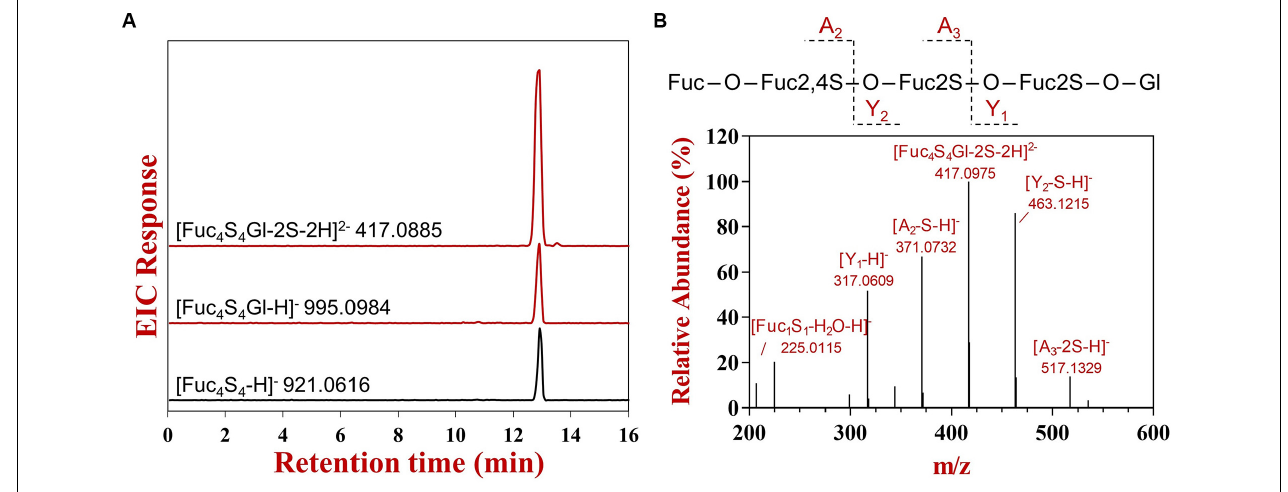
FIGURE 4 | The UPSEC-MS analysis of hydrolysis and transglycosylating products produced by FunA in the reaction system with glycerin as the acceptor. (A) Extraction ion chromatograms; (B) MS/MS spectrum of [Fuc 4 S 4 Gl-2S-2H] 2 − . “Fuc” represented fucose residue, “Gl” represented glycerin residue, “S” represented sulfate group, “O” represented oxygen from the glycosidic bond. The charge number of fragment was provided by the instrumental software (Agilent Masshunter Qualitative Analysis Navigator B.08.00).